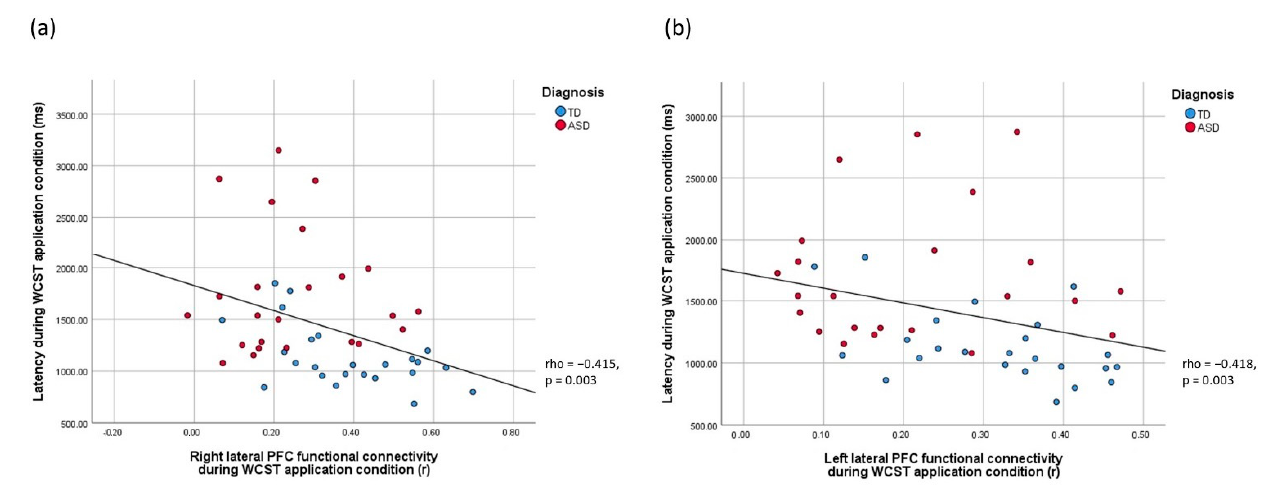
Figure 5. Scatter plots showing the brain-behavior relationships between WCST response latency during WCST application condition and lateral PFC functional connectivity in the ( a ) right and ( b ) left hemispheres, respectively. Red dots represent data from the ASD group, blue dots represent data from the TD group.